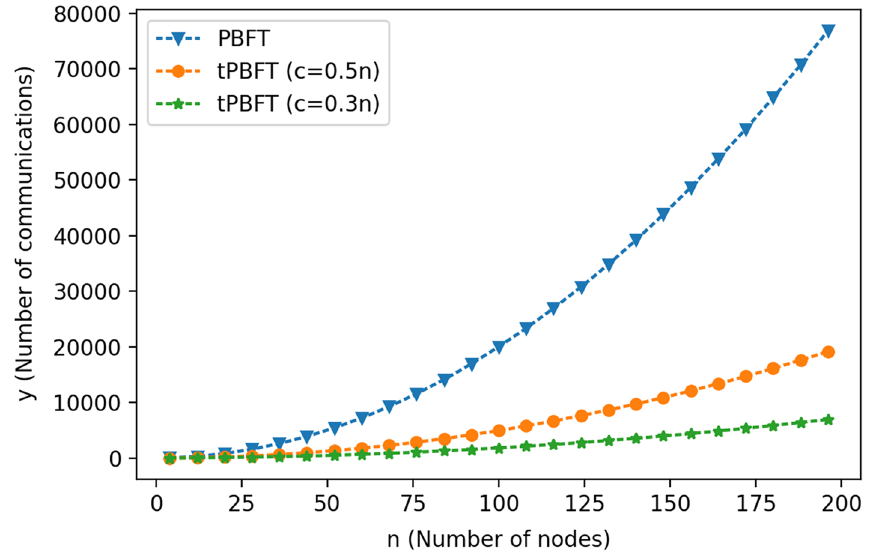
Figure 7. Comparison of communication times between tPBFT and PBFT algorithms.